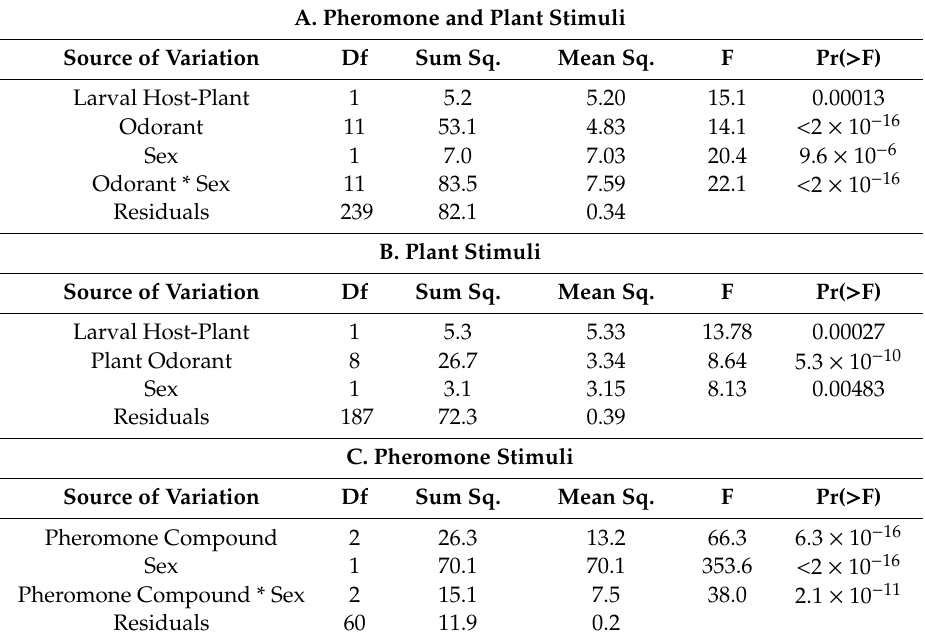
Table 3. ANOVA results using di ff erent data sets. (A) All the odorant stimuli (pheromone and plant compounds), (B) plant compounds only, (C) pheromone compounds